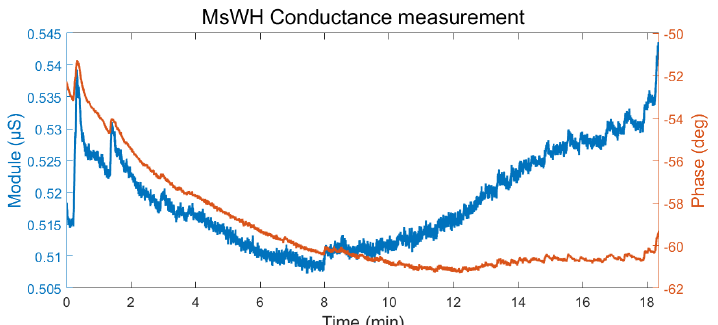
Figure 19. MsWH conductance measurement. Raw data. Left axis: module ( µ S). Right axis: phase